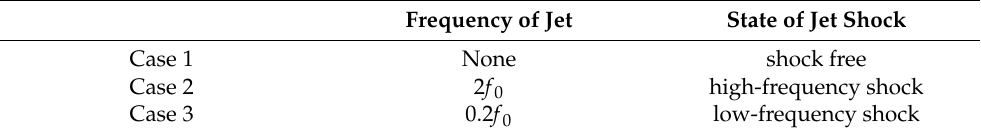
Table 2. Simulation conditions for three cases.